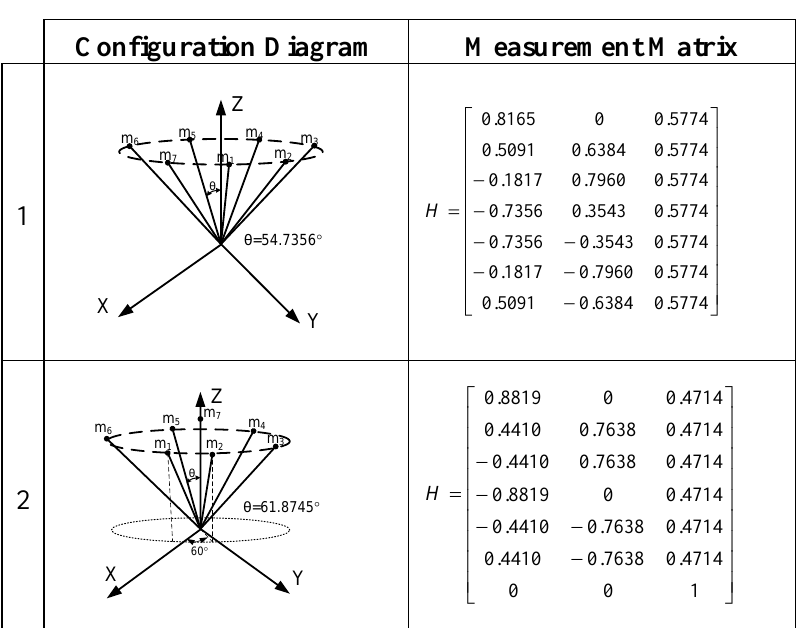
Table 5 . Configurations which satisfy